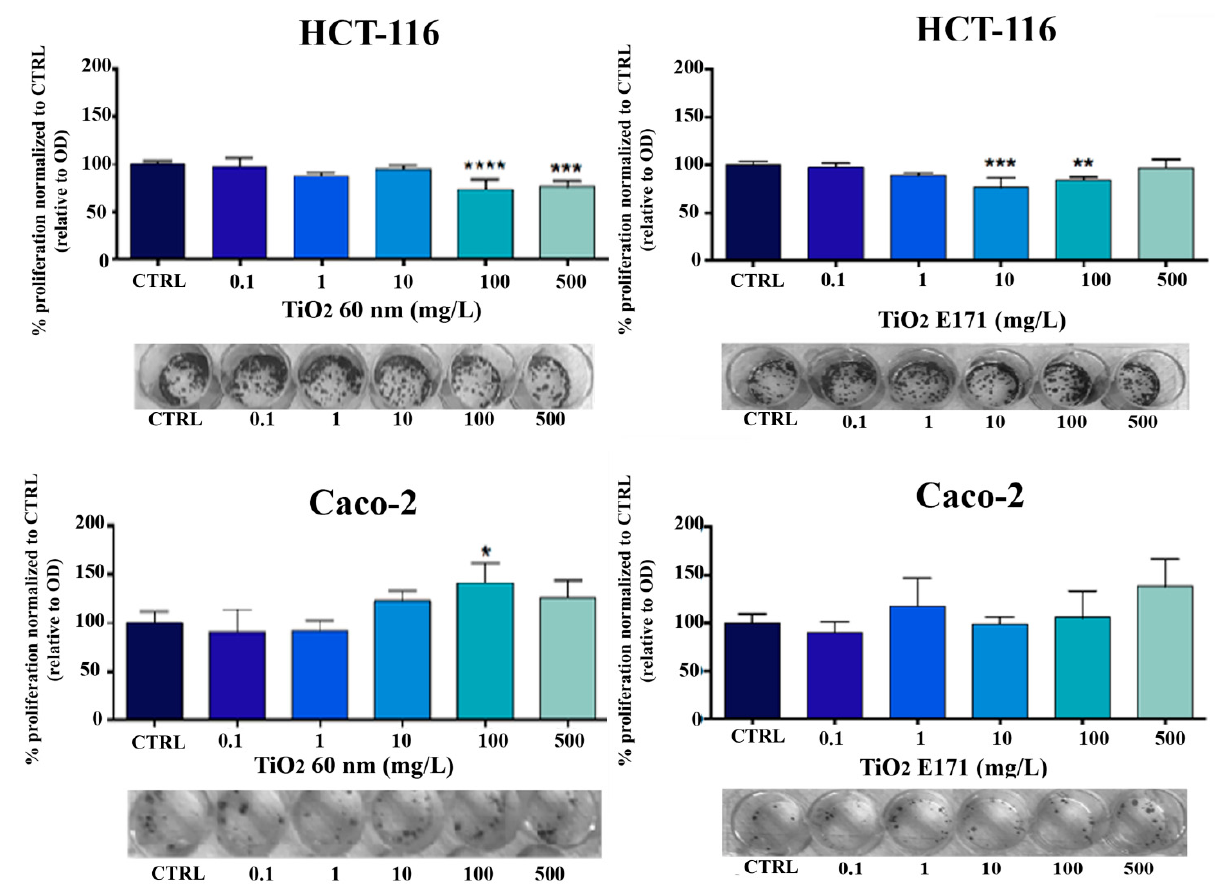
Figure 5. Clonogenic assay: HCT-116 and Caco-2 cell lines, 72 h post-treatment with TiO 2 -NPs and E171 (0; 0.1; 1; 10; 100; 500 mg/L), were seeded at 200 cells per well onto 24-well culture plates and allowed to grow for one week in complete RPMI-1640 media. The cells treated with TiO 2 were compared to untreated cells (CTRL). * p < 0.05 vs. control; ** p < 0.01 vs. control; *** p < 0.001; **** p < 0.0001 vs. control.